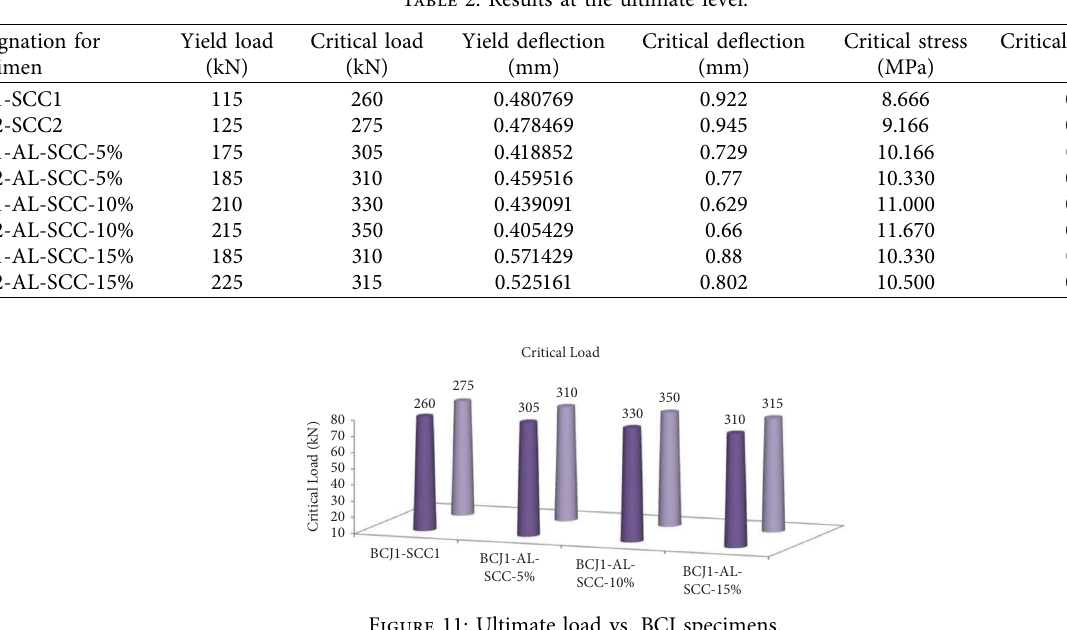
Figure 10: Yield load vs. BCJ specimens. Table 2: Results at the ultimate level.